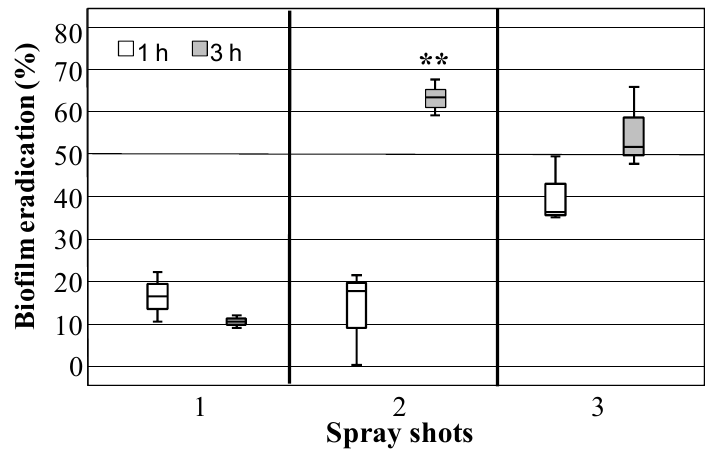
Figure 5. Biofilm eradication percentage of S. epidermidis UR63 determined on microscope cover glass slides sprayed one, two, or three times with sterile water or bovine lactoferrin hydrolysate (HLF) aqueous solution (2.5 mg / mL, corresponding to 0.54, 0.99, 1.5 mg of HLF as dry matter) and incubated for 1 or 3 h at 37 ◦ C. ** Asterisks indicate a statistically significant di ff erence ( p < 0.01) between the incubation time at a fixed spray shot